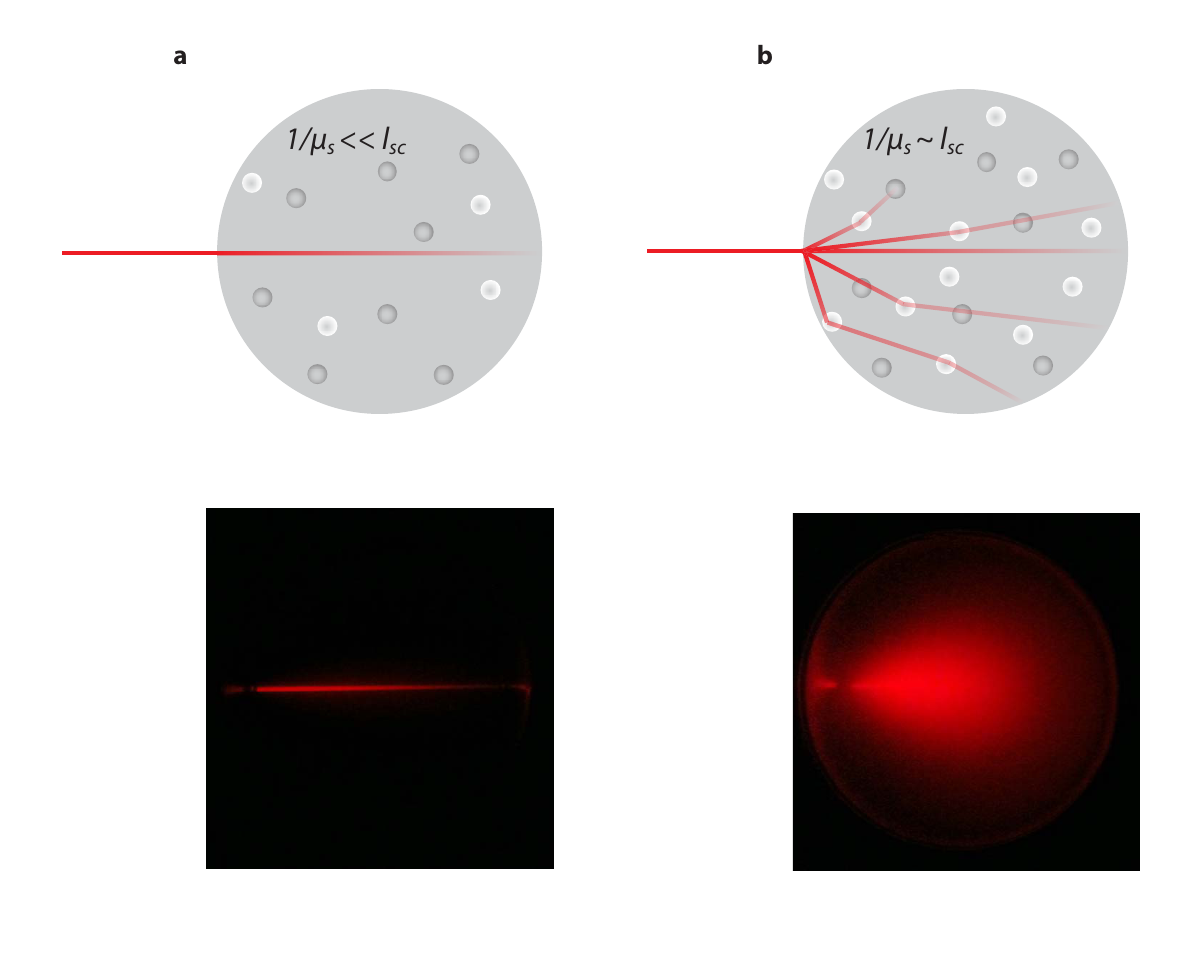
Figure 1. Light propagation in tissue: ( a ), Highly absorbing medium where the mean free path l defining the distance between two scattering events is large compared to sc 1 /µ , µ being the scattering coefficient. In this case the light intensity decreases with s s the distance d according to I ∝ I exp( − µ d ) where µ = µ + µ . ( b ), Highly scattering 0 t t s a medium where l is approximately 1 /µ . This case represents the situation in tissue sc s where light propagation can be modeled with diffusion